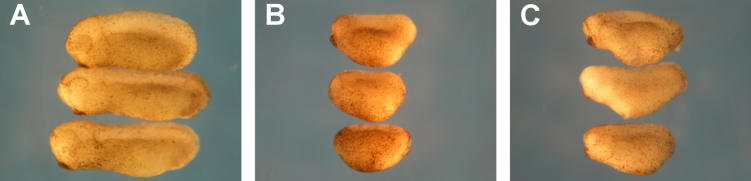
Delangin and MAU-2 Regulate Similar Processes in
Xenopus tropicalis Embryonic Development
Antisense morpholino oligonucleotides (MO) were used to target specific mRNAs to inhibit production of
X. tropicalis delangin or MAU-2 (see
Materials and Methods). Embryos injected with control MO exhibit normal development (A). Embryos targeted to knock down delangin or MAU-2 both exhibit a delay in development from gastrula stages relative to control MO-injected embryos, however they look normal at this stage. By late tailbud stage (stage 28), delangin morphants (B) are severely truncated along the A-P axis and ventralized, exhibiting retarded dorsal tissue development, particularly in the neural tube and somites. Head, eye, and tail development are also defective. MAU-2 morphants (C) exhibit a very similar but less severe phenotype than is evident in delangin morphants, including shortening of the A-P axis, ventralization and defects in neural, somite, head, eye, and tail development relative to the control MO-injected embryos.